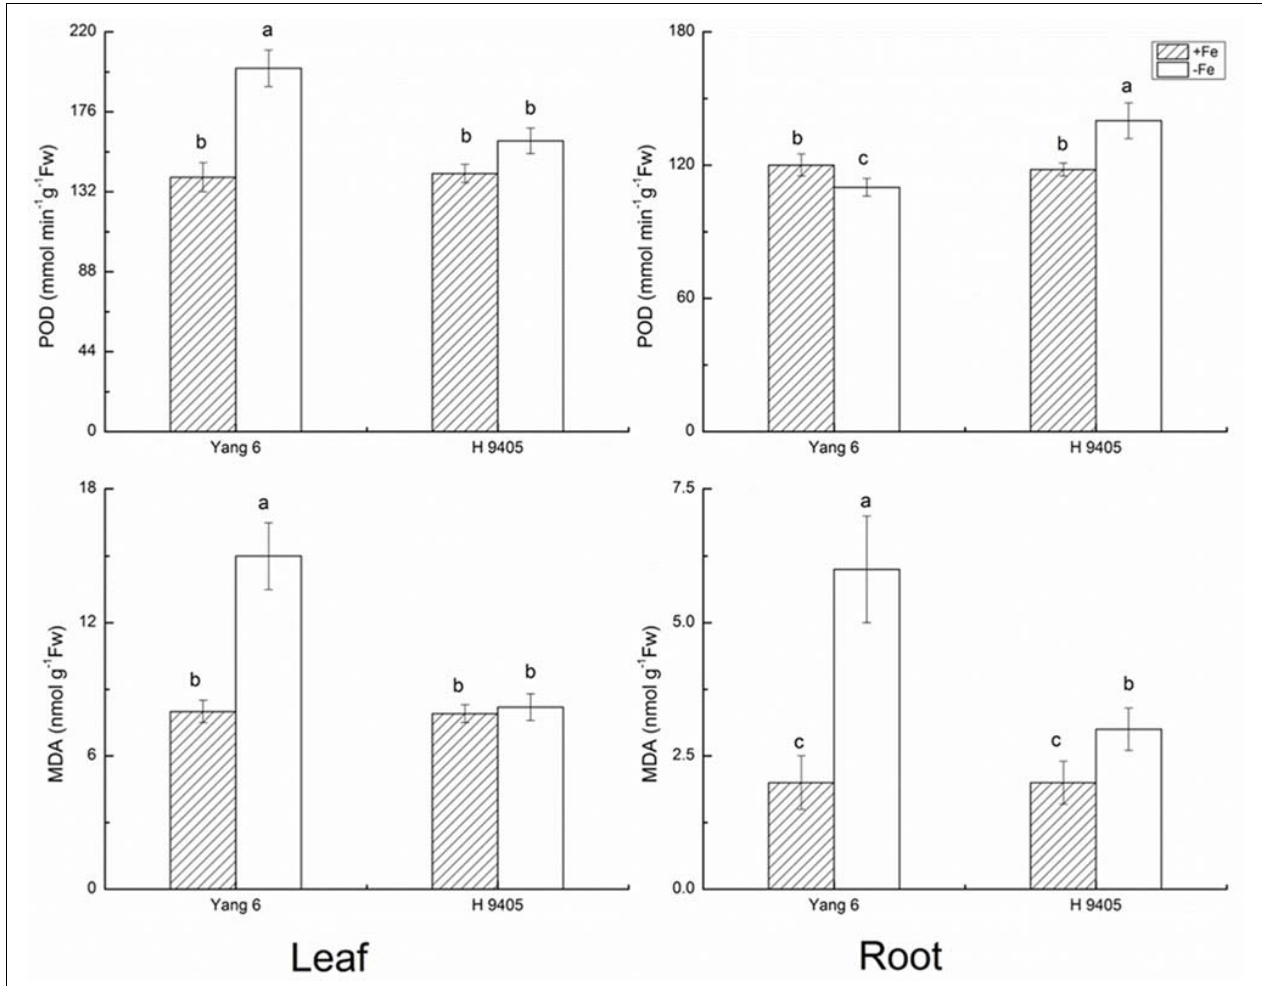
FIGURE 2 | Effects of iron deficiency on POD and MDA contents in leaves and roots of rice seedlings. Data are presented as means ± SE of three biological replicates. Significant differences among treatments are indicated by different letters as determined by Duncan’s test ( P <